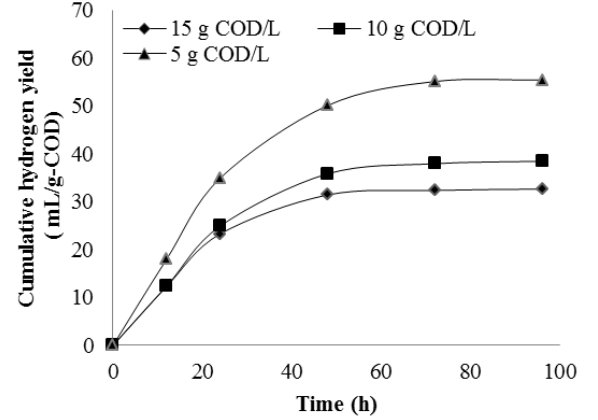
Fig. 1. The effect of substrate concentration on the hydrogen yield at constant initial pH of